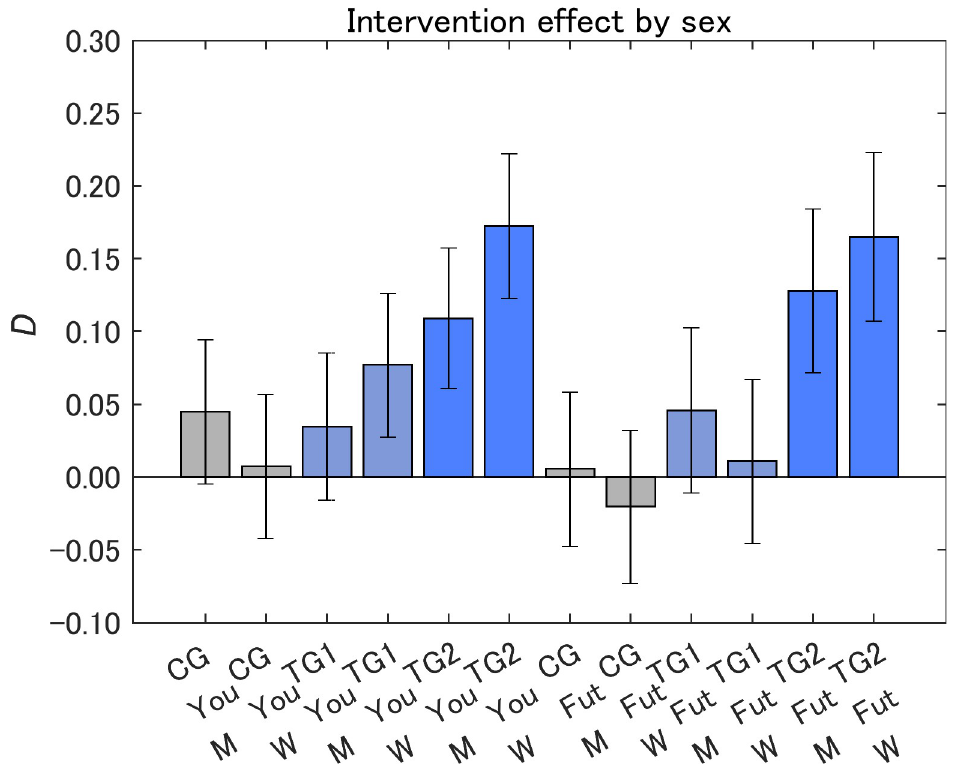
Fig 12. Attitude change toward IT innovations after receiving a designed message ( D ) by sex. The value on the vertical axis is higher the less dangerous the perception of IT innovations became. M, men; W, women. Error bars show 95% confidence